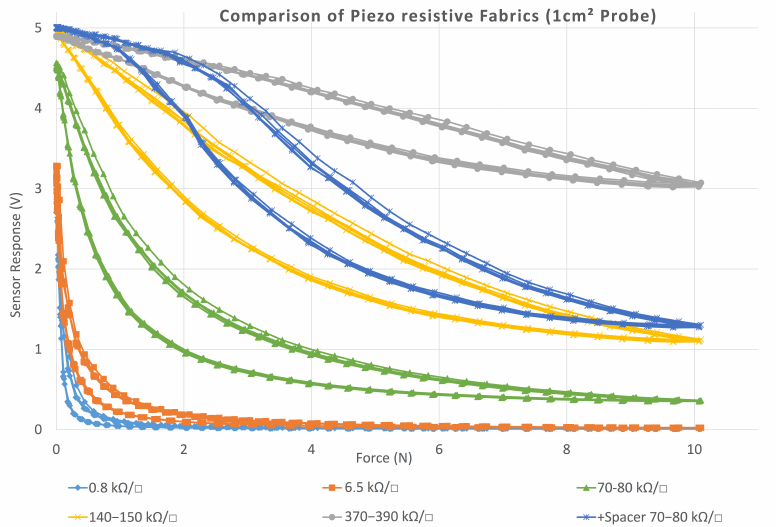
Figure 7. Tactile sensor characteristics was measured using a 1 cm 2 flat probe tip. Curves of like colors represent a measurement sweep of increasing and decreasing force in the range of 0–10 N for a specific material. All curves exhibit hysteresis that is common to piezo-resistive sensors. We have chosen the material that best covers the whole measurement range of 0–5 V, namely the fabrics with a surface resistance of 70–80 k Ω / (cid:3) without the spacer layer ( Ω / (cid:3) indicates the unit of surface resistivity).